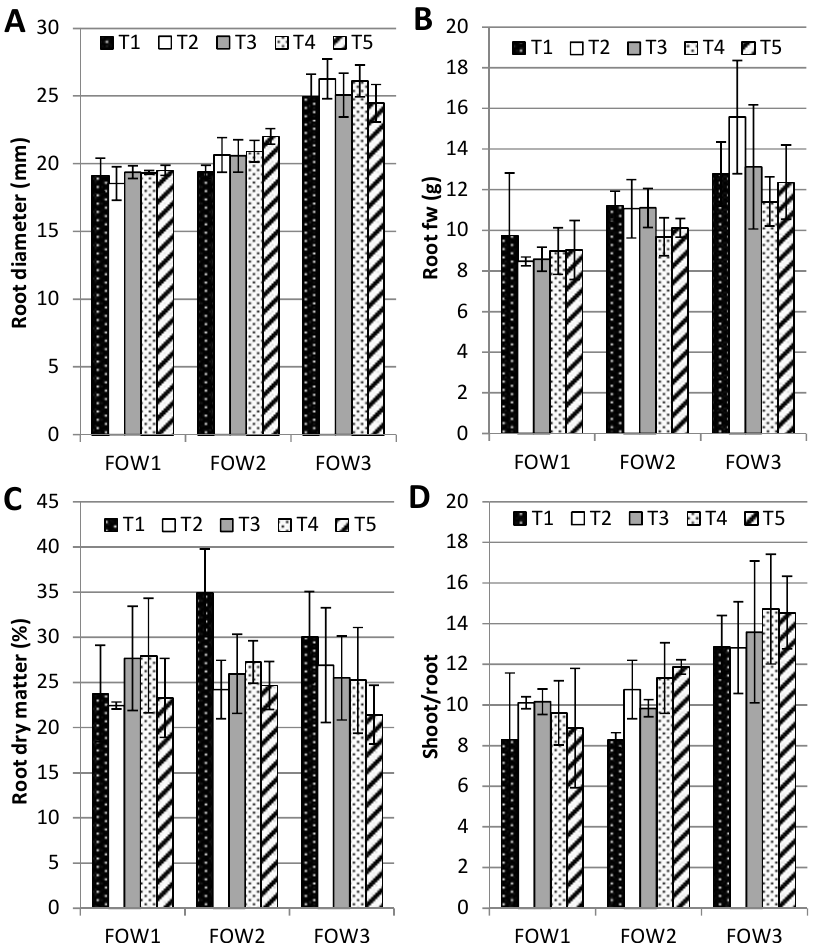
Figure 7. Different effects of 6-benzylamino purine (BAP) treatments on morphological and weight traits of harvested offshoots from field mother plants according to their size: ( A ) root diameter, ( B ) root fresh weight, ( C ) root dry matter, ( D ) shoot/root ratio. Standard errors are reported. T1: 0 ppm + no cut-back; T2: BAP 0 ppm + cut-back; T3: BAP 100 ppm + cut-back; T4: BAP 200 ppm + cut-back; T5: BAP 300 ppm + cut-back; FOW1: field offshoot weight <100 g; FOW2: 100 g ≤ field offshoot weight ≤150 g; FOW3: field offshoot weight >150 g.